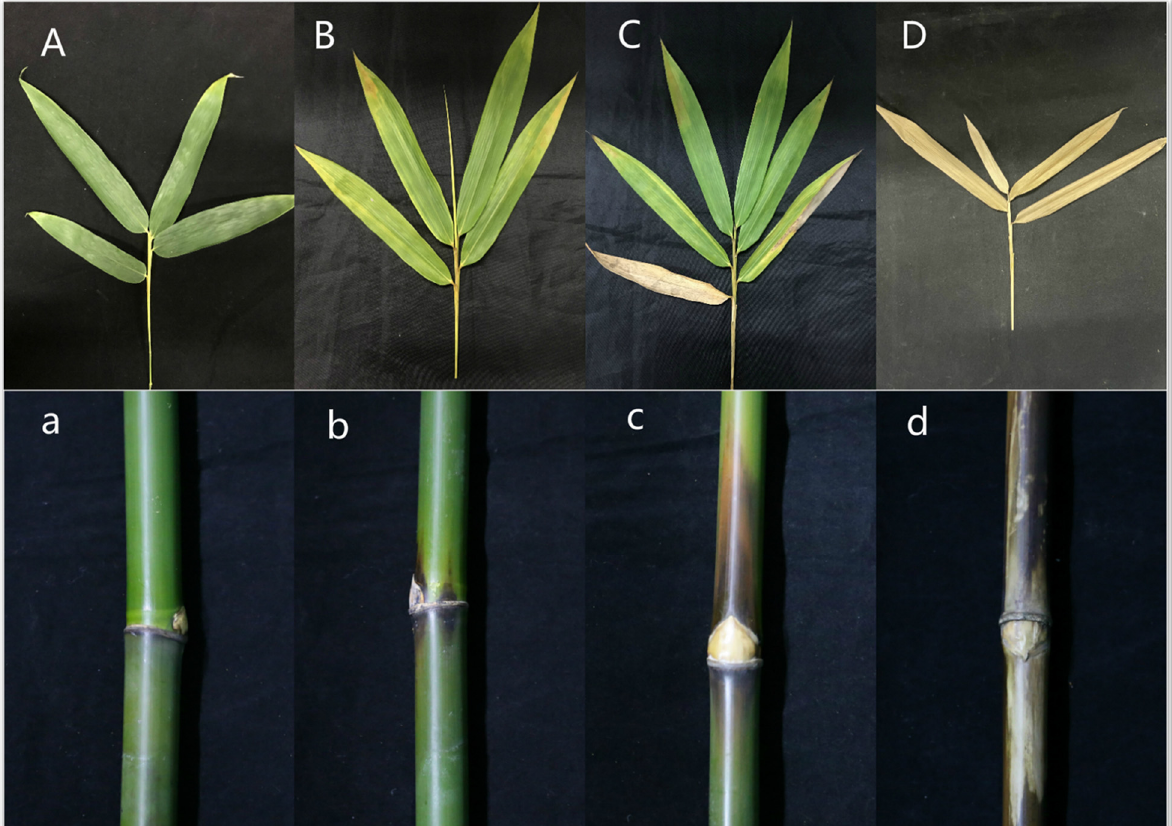
Figure 13. Symptoms of branches and leaves of plants infected with sterile water, ∆ Ap Ctf1 β 1 and ∆ Ap Ctf1 β 2 and wild-type strains after 25 days. Note: ( A , a ) are the symptoms of B. pervariabilis × D. grandis leaves and branches inoculated with sterile water for 25 days, respectively. ( B , b ) are the symptoms of B. pervariabilis × D. grandis l eaves and branches inoculated with ∆ Ap Ctf1 β 1 strain for 25 days, respectively. ( C , c ) are the symptoms of B. pervariabilis × D. grandis l eaves and branches inoculated with ∆ Ap Ctf1 β 2 strain for 25 days, respectively. ( D , d ) are the symptoms of B. pervariabilis × D. grandis l eaves and branches inoculated with wild type strain for 25 days,